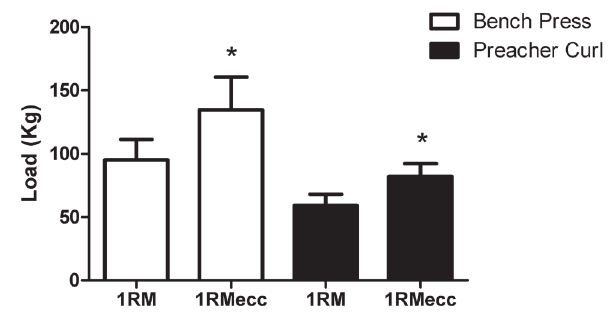
Figure 1. One repetition maximum (1RM) and one repetition maximum eccentric (1RMecc) test for the bench press and the preacher curl exercise. * Significant difference ( p < 0.05) compared to the 1RM test. The data are expressed as mean ± SD ( n = 15).